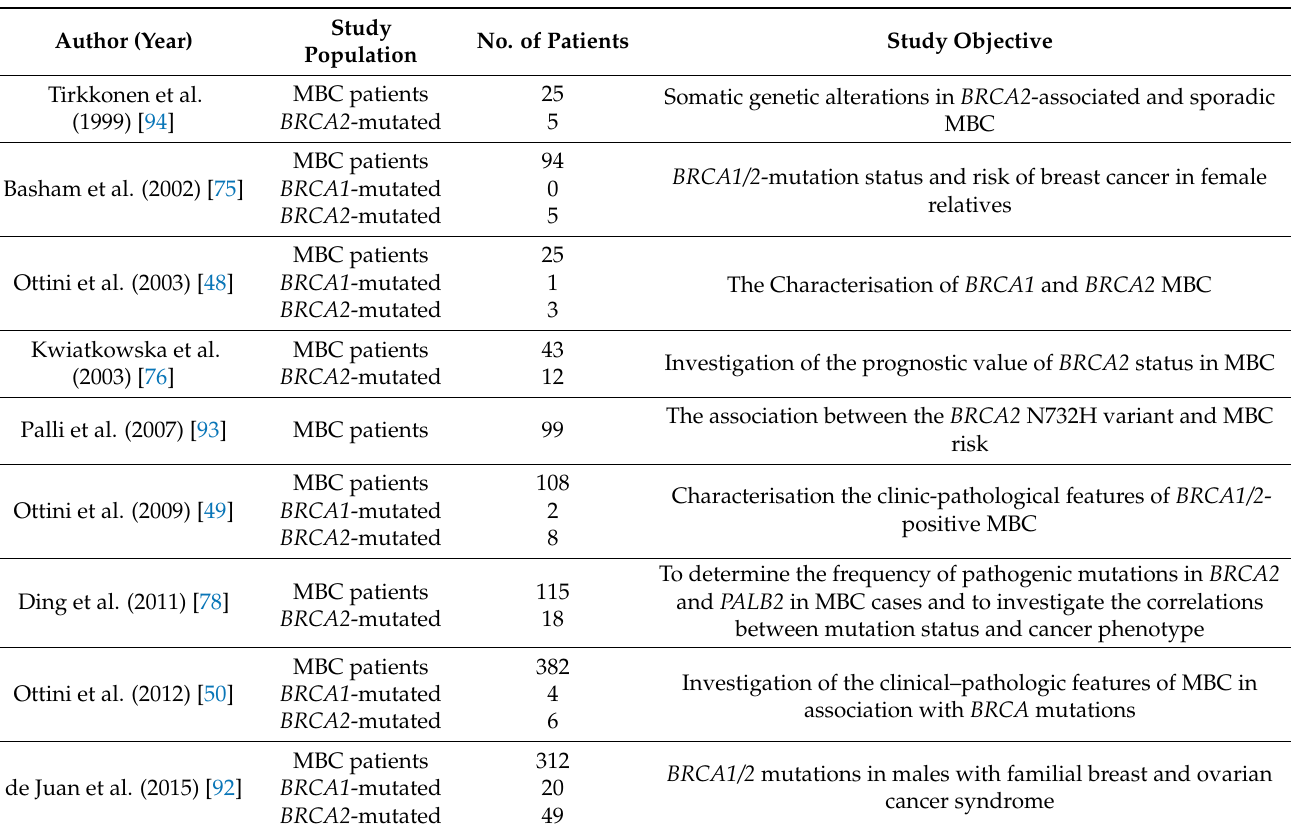
Table 1. Summary of retrospective studies involving BRCA -positive MBC